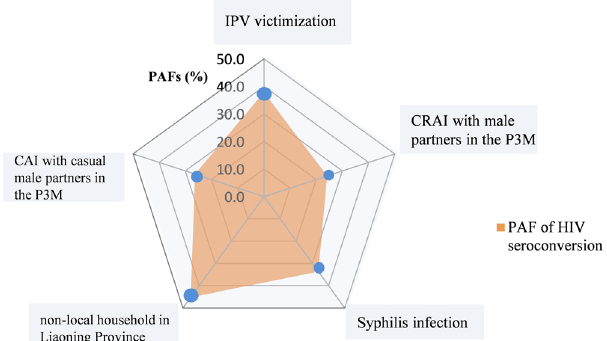
Figure 2. Population attributable fraction of risk factors for HIV seroconversion among Shenyang